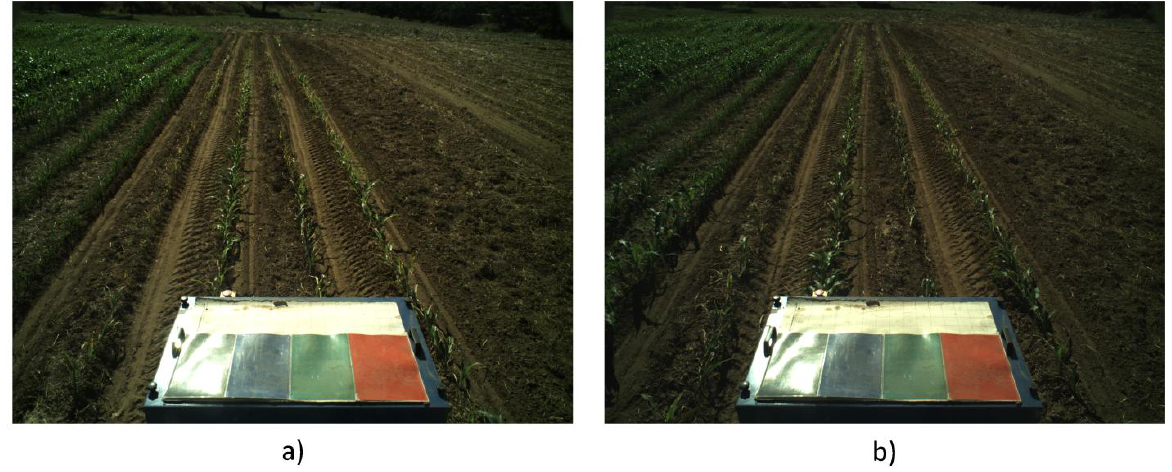
Figure 12. Consecutive original images acquired by the perception system. ( a ) Deviations of the tractor with respect to the crop lines; ( b ) Correction of this